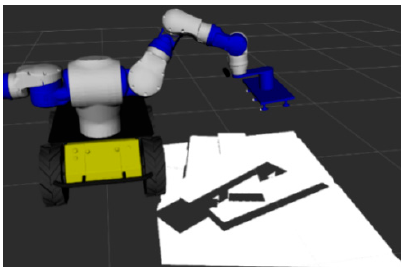
Figure 17. Original point cloud.